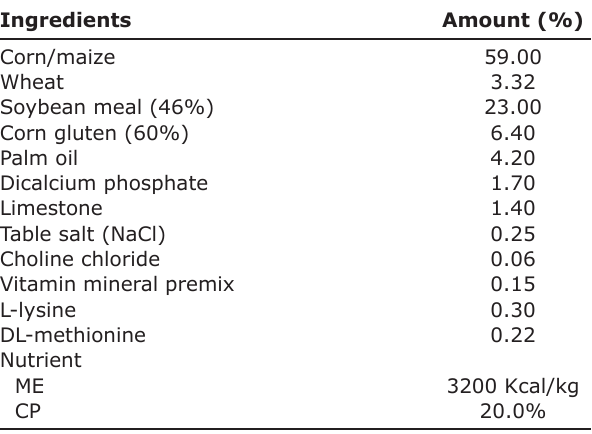
Table-1: Composition of broiler grower feed.